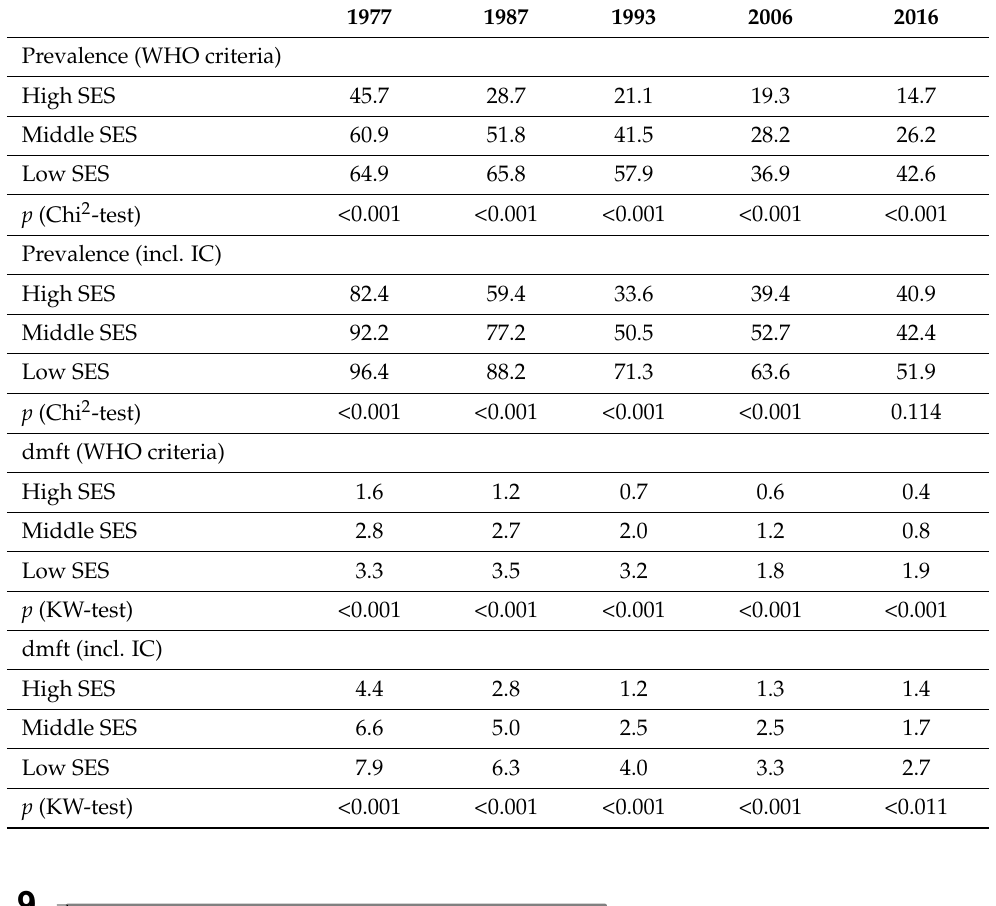
Table 2. Caries prevalence and dmft-values (both according to WHO criteria and including initial caries,